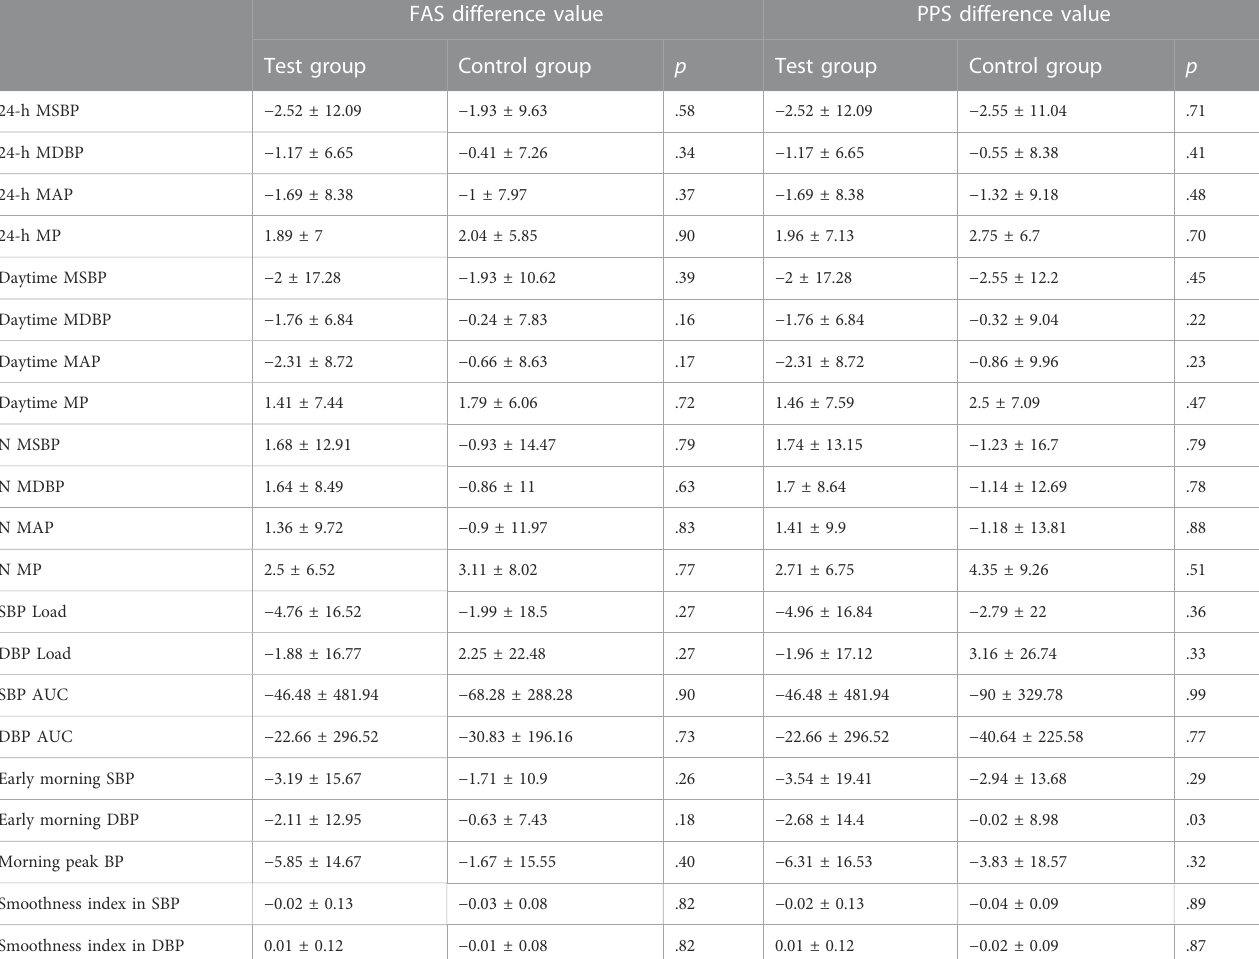
TABLE 2 Changes in 24-h ABPM values.